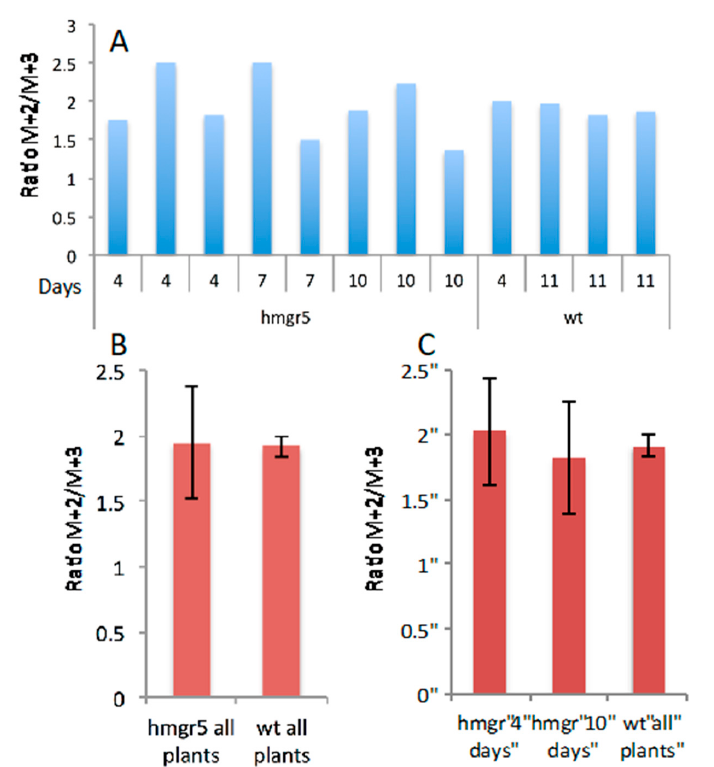
Figure 9. Figure 9. 13 C enrichment in camphor. Excess values of M+2 and M+3 isotopomeres obtained from